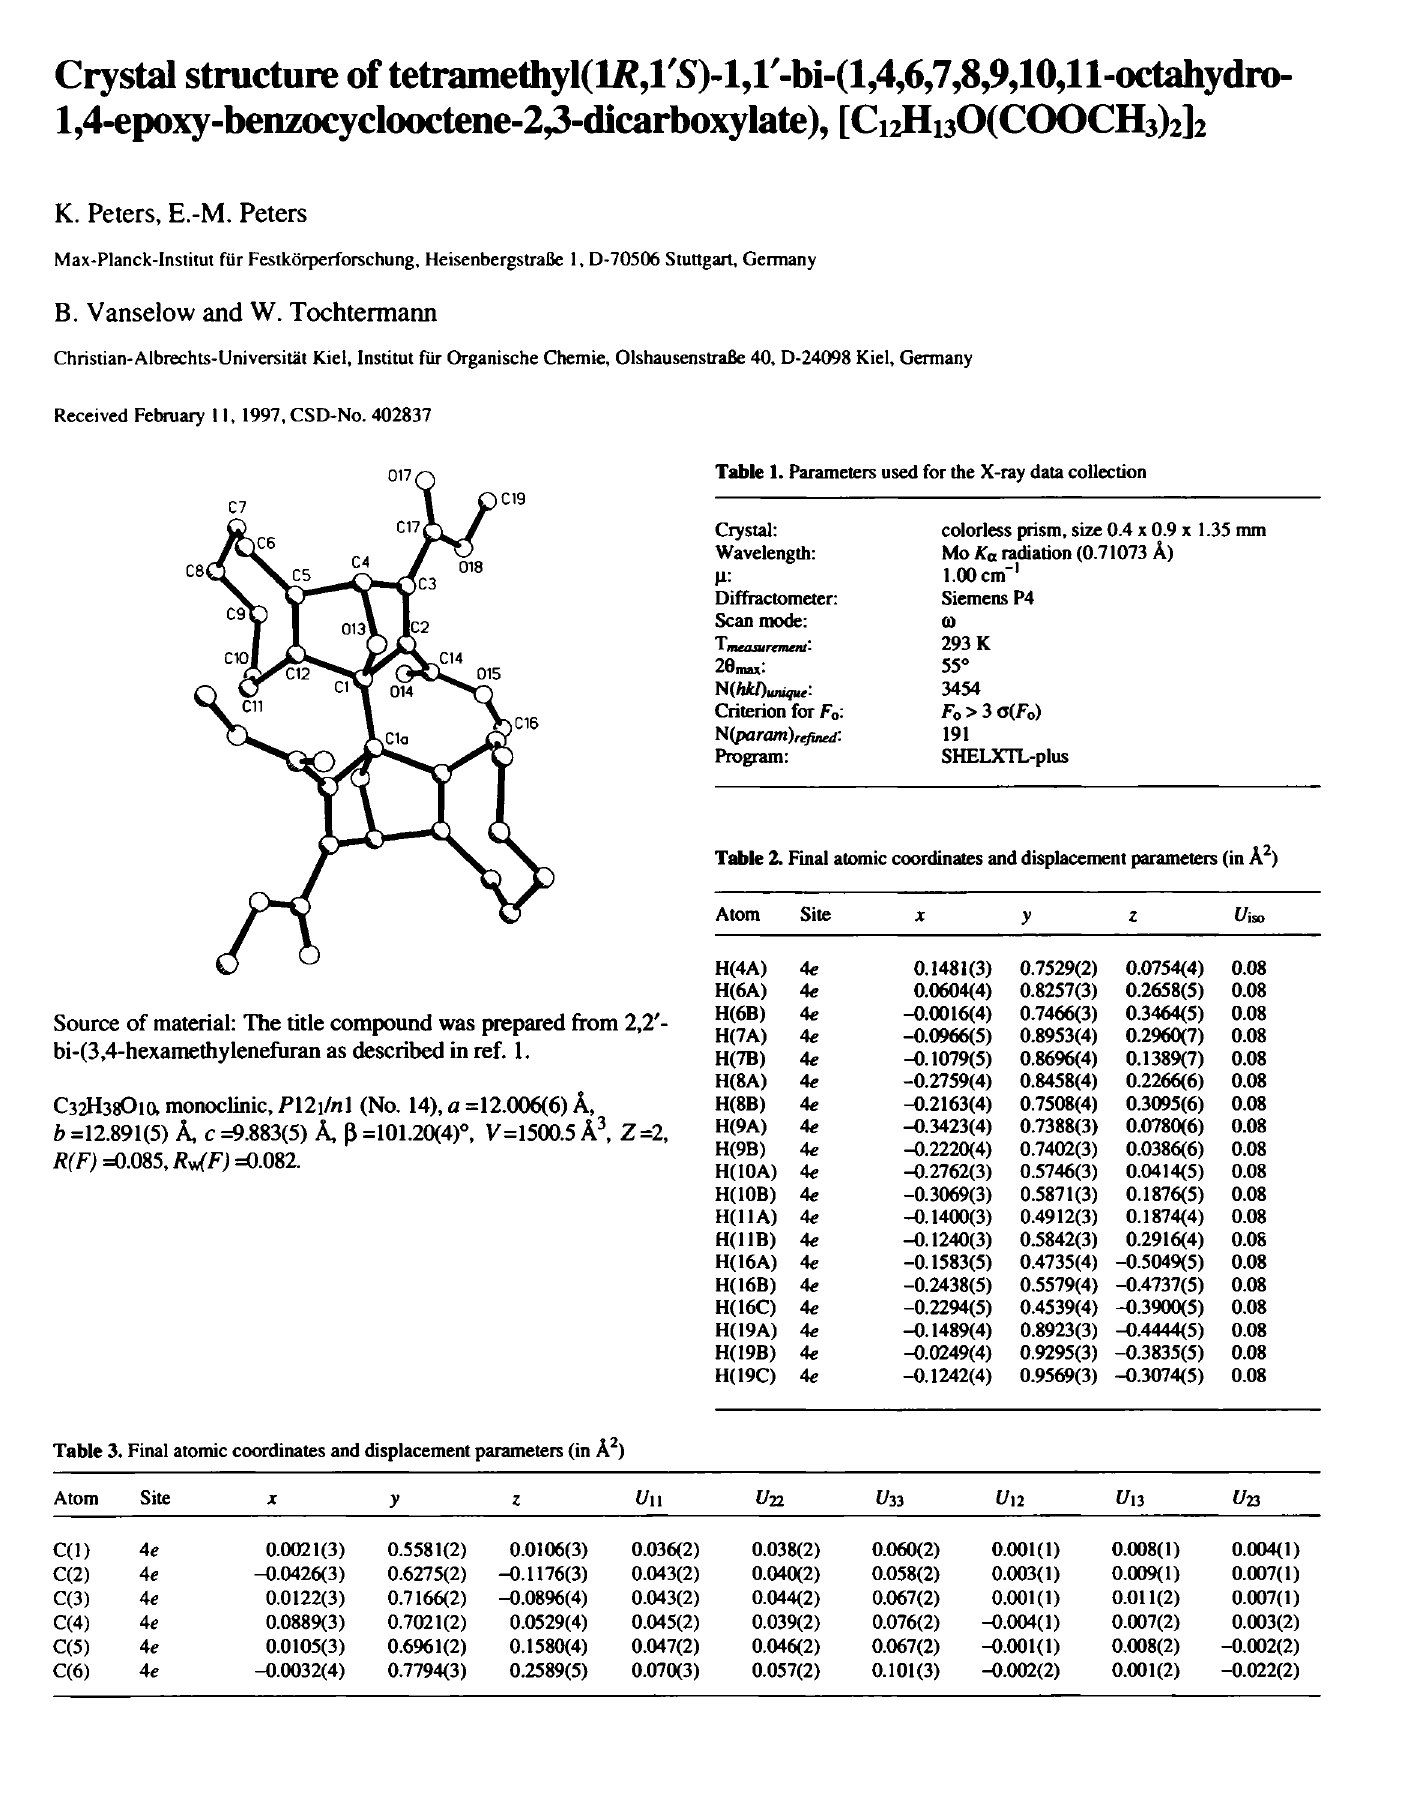
Table 1. Parameters used for the X-ray data collection Crystal: